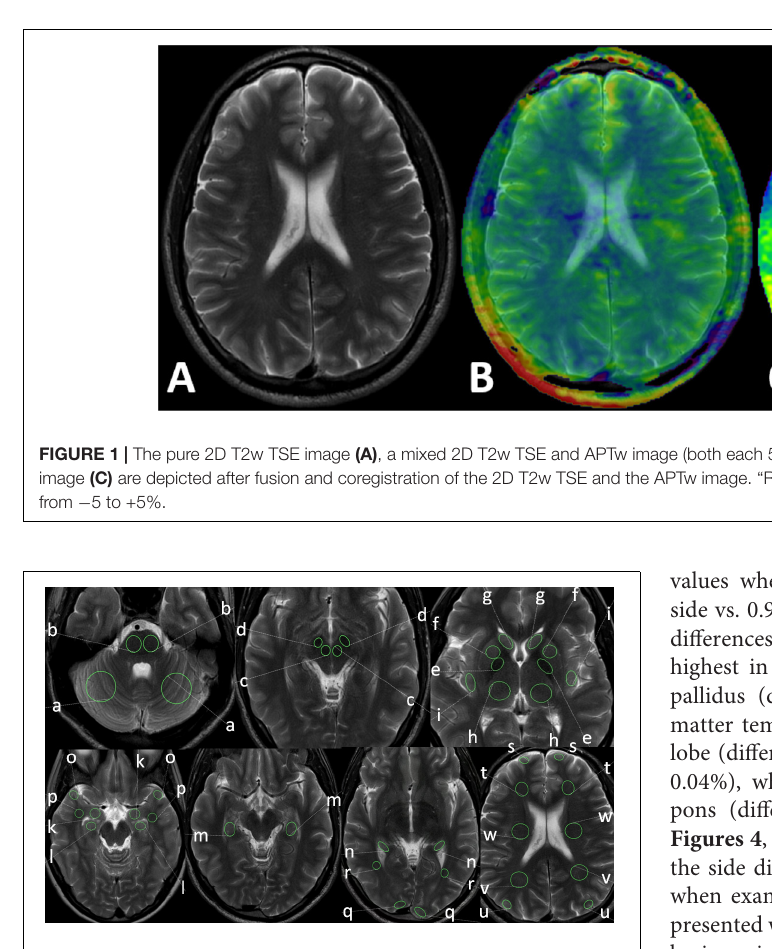
and parietal white matter between 0.32 and 0.54% and in the temporal white matter between 0.83 and